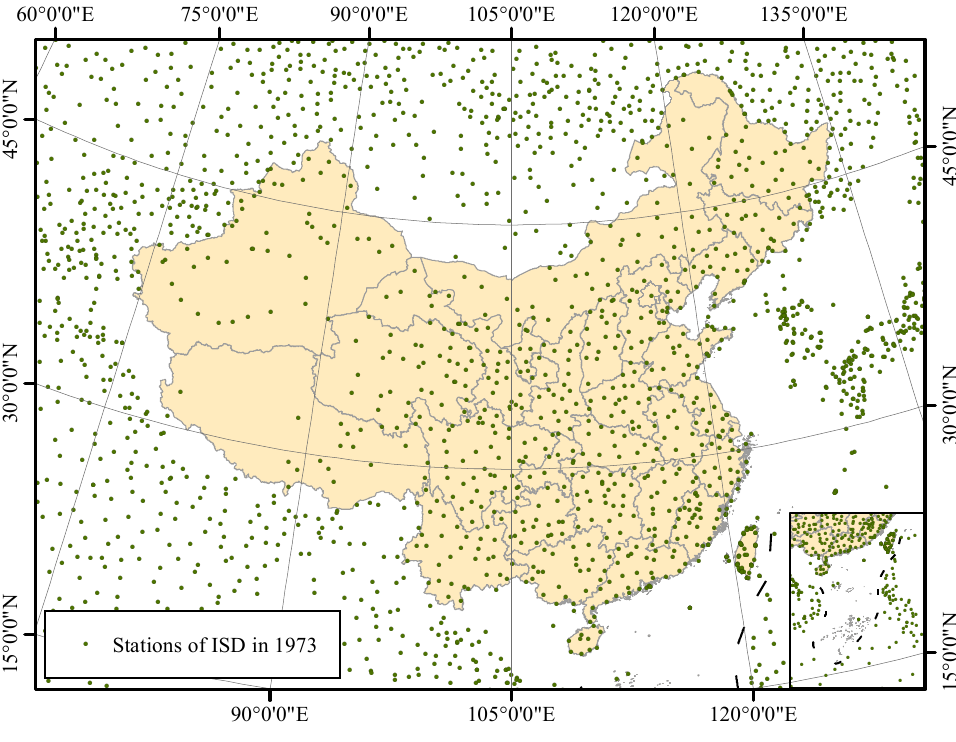
Figure 2. ISD stations in or near China in